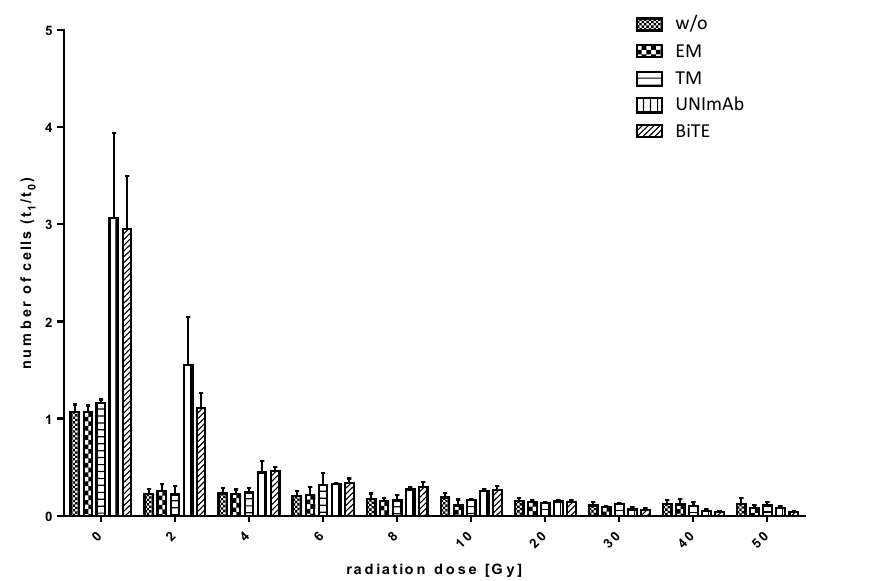
Figure 8. Expansion of irradiated T cells. Irradiated and unirradiated pan T cells were redirected to PC3-PSCA cells in the absence (w/o) or presence of 30 pmol/mL of the respective Ab components (effector module alone (EM), target module alone (TM), UNImAb complex (UNImAb), conventional BiTE (BiTE)) for 5 d. The absolute numbers of T cells were estimated and the ratio (t 1 /t 0 ) was calculated. Summarized data of three individual donors are shown.